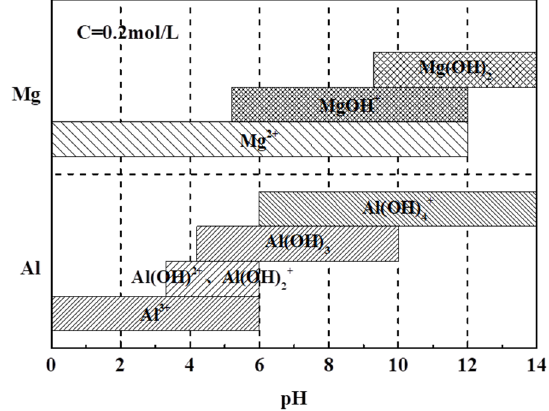
Figure 7. Hydrolyzed component concentration diagram of Mg 2+ and Al 3+ .